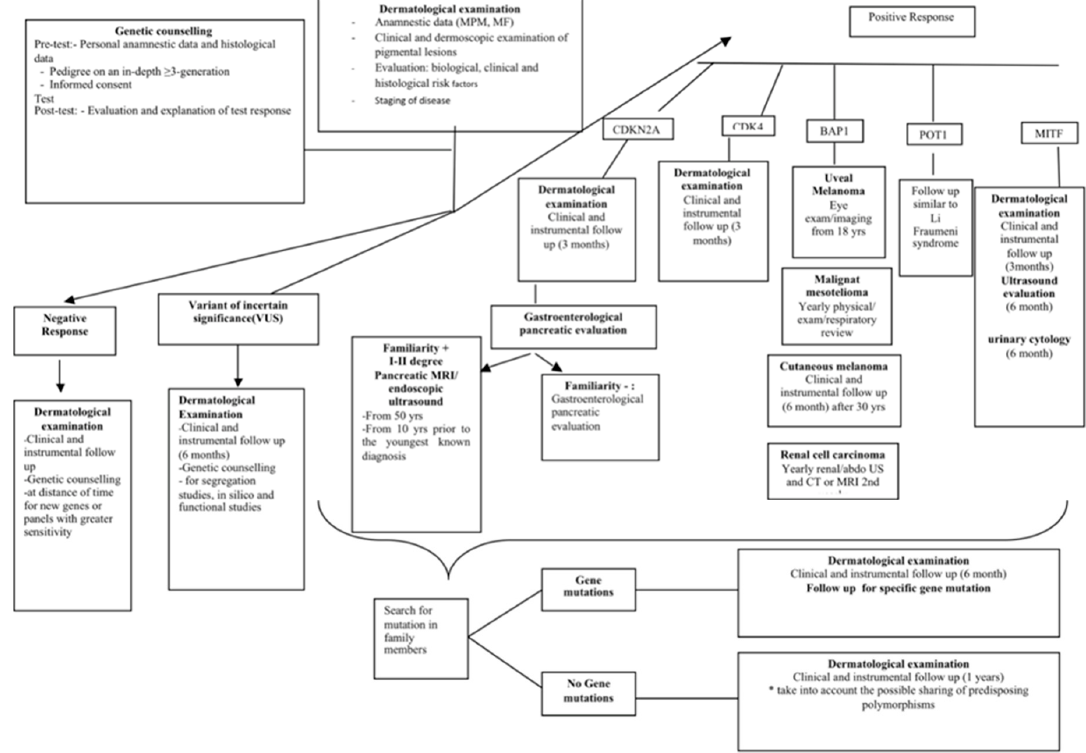
Figure 6. Flow chart on the therapeutic diagnostic path of the patient with familial melanoma or / and multiple primary